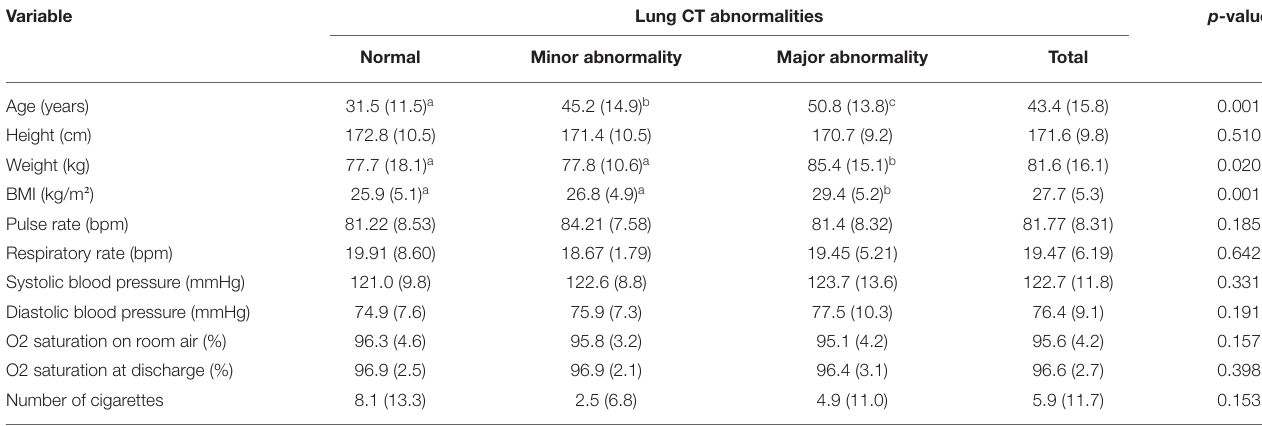
TABLE 2 | Means of anthropometric and medical variables among the study participants based on lung CT